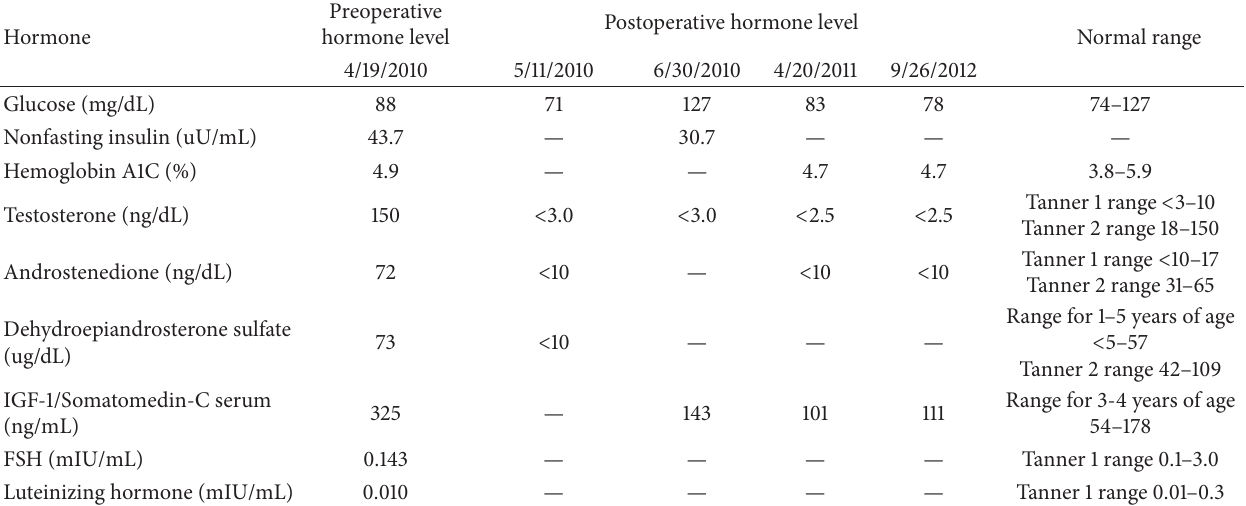
Table 1: Pre- and postoperative endocrine laboratory